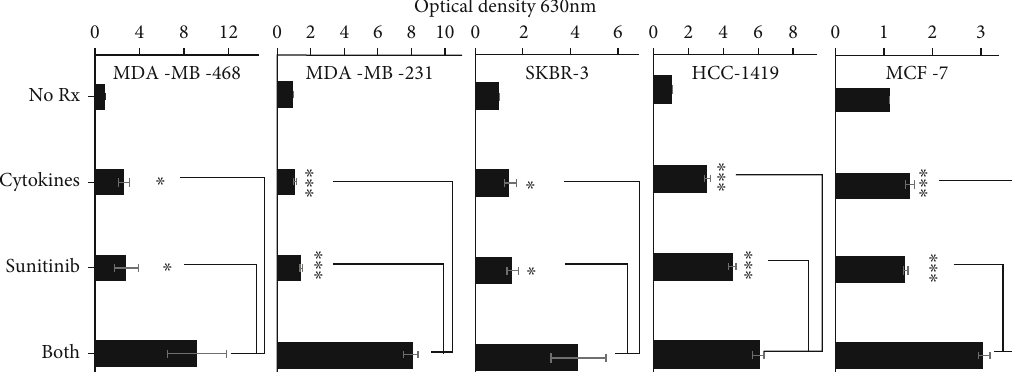
Figure 1: Metabolic activity of breast cancer cell lines is maximally suppressed by Th1 cytokines and sunitinib treatment. MDA-MB-468, MDA-MB-231, SKBR-3, HCC-1419, and MCF-7 cells were seeded at 5 × 10 3 cells per well and were left either untreated (No Rx) or treated with Th1 cytokines (5 ng/mL each IFN- γ and TNF- α ), sunitinib (10 μ M), or sunitinib and Th1 cytokines (both). After 72 hours of incubation, Alamar Blue dye was added to each well. When a color change became apparent, the optical density of the supernatants was read via spectrophotometry at 630 nm. Data represent the summary analysis of at least three separate experiments per cell line. Statistical signi fi cance was determined by one-way ANOVA: MDA-MB-231 ( F ð 3, 56 Þ = 242 : 8 , p < 0 : 001 ), MDA-MB-468 ( F ð 3, 24 Þ = 5 : 84 , p < 0 : 004 ), MCF-7 ( F ð 3, 56 Þ = 146 : 3 , p < 0 : 001 ), HCC-1419 ( F ð 3, 56 Þ = 95 : 2 , p < 0 : 001 ), and SKBR-3 ( F ð 3, 16 Þ = 5 : 94 , p < 0 : 006 ), followed by the post hoc Tukey. Error bars show the standard error of the mean.